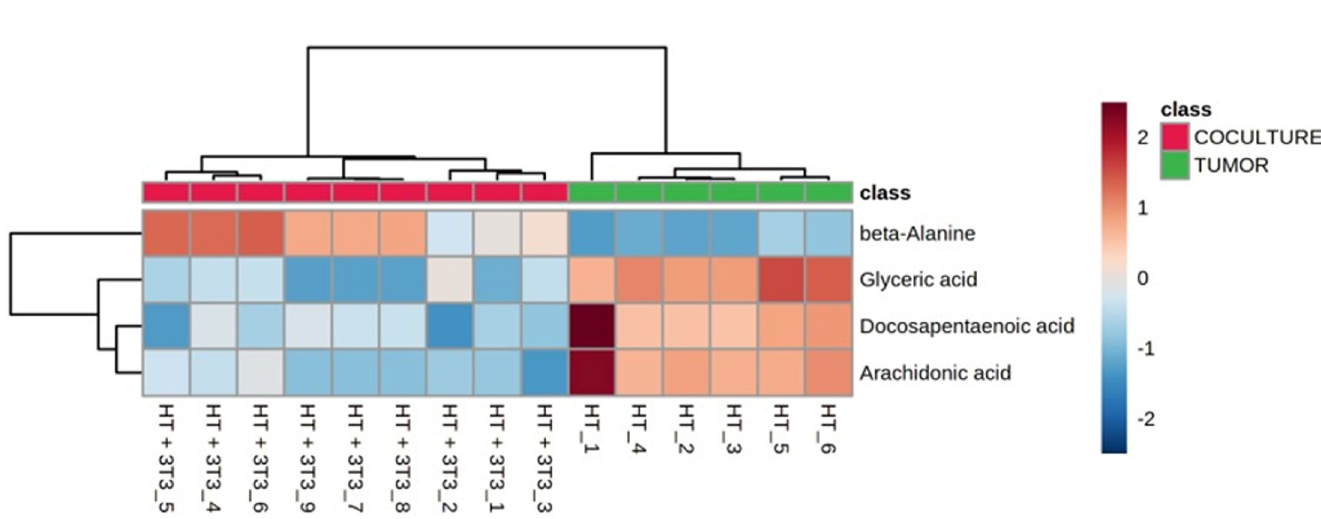
Fig 1. Heatmap of the metabolites from HT spheroids impacted by the co-culture with 3T3 adipocytes. The colors are normalized to the relative abundance of each metabolite. Samples (vertical axis) and metabolites (horizontal axis) are separated by Ward’s algorithm and the dendrogram was scaled using Pearson’s correlation. The clusters containing tumor spheroid alone and co-culture with tumor and adipocyte spheroids are highlighted in green and red,